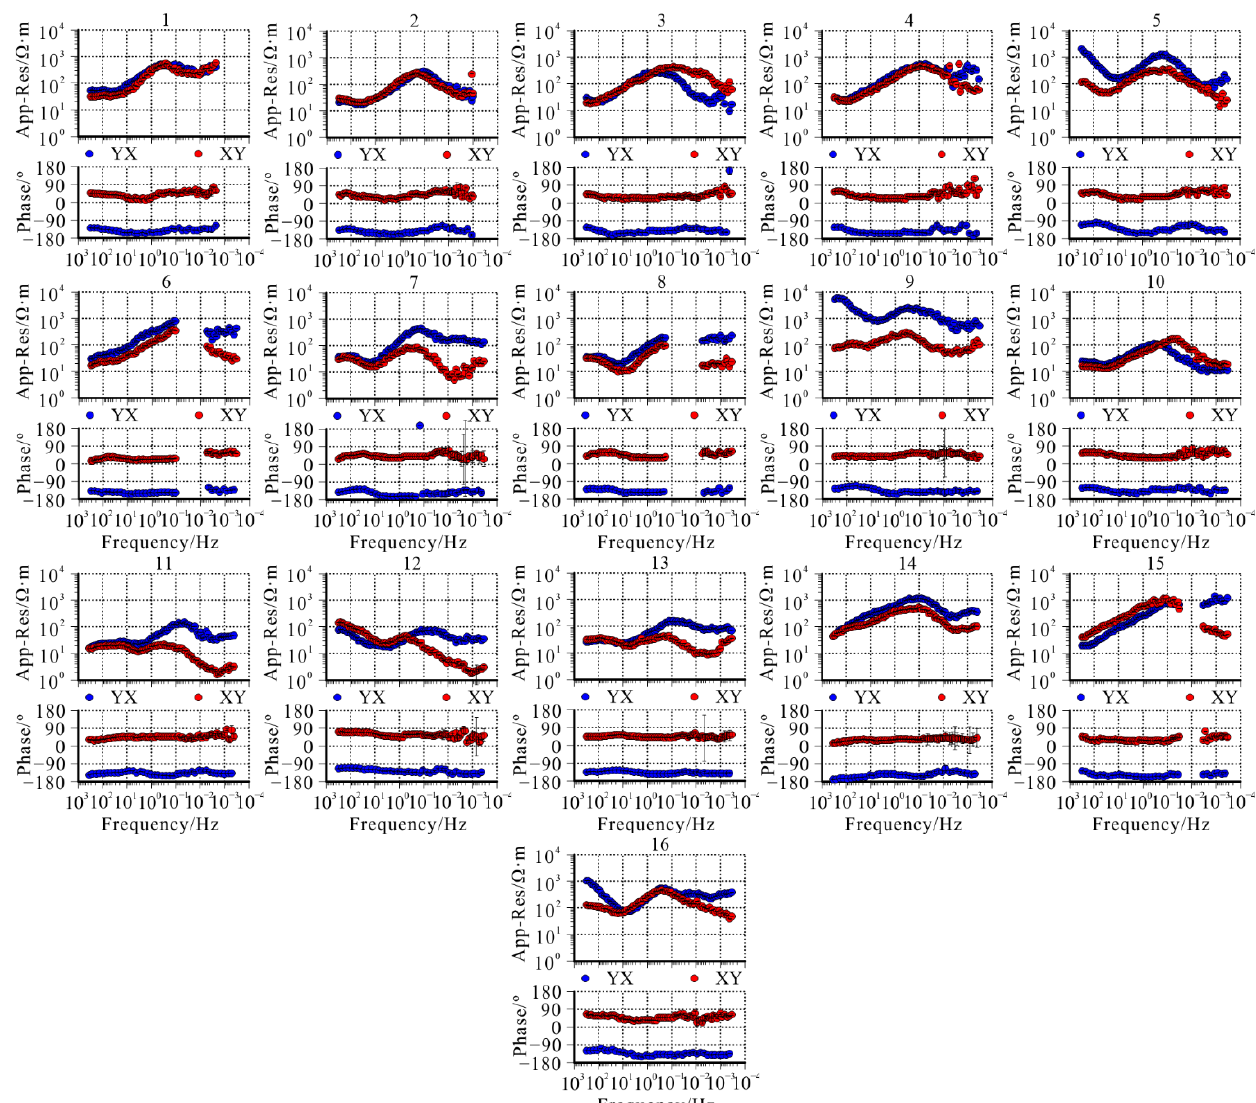
Figure 3. Typical measured point apparent resistivity (App-Res) phase curve (Off-diagonal impedance component YX and XY).